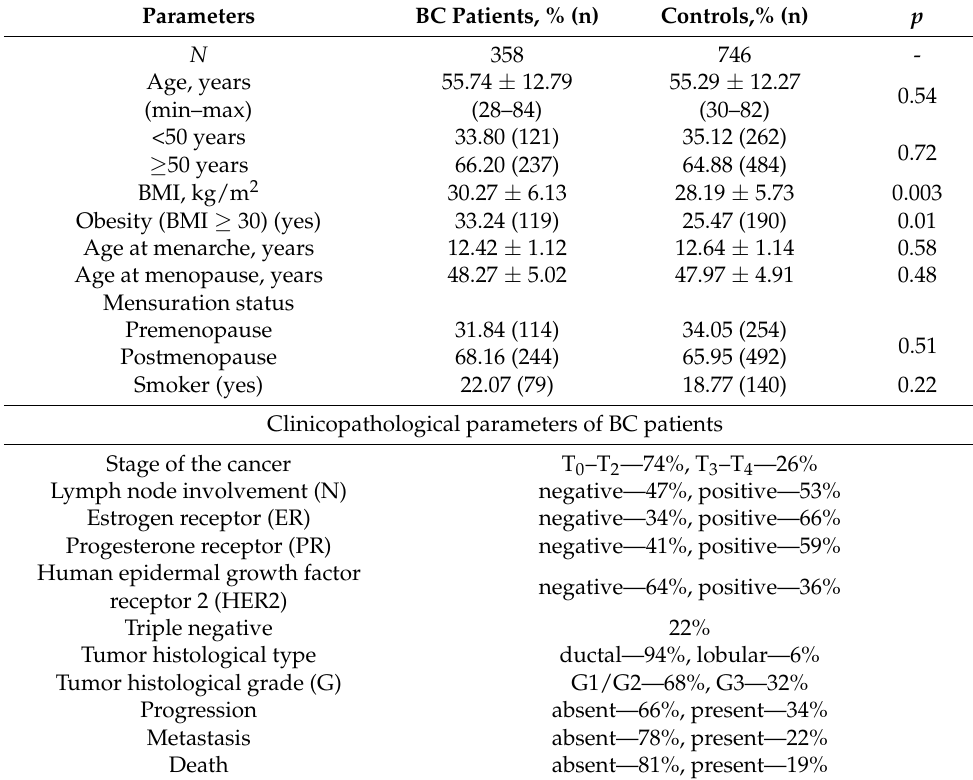
Table 1. Phenotypic characteristics of the study participants.